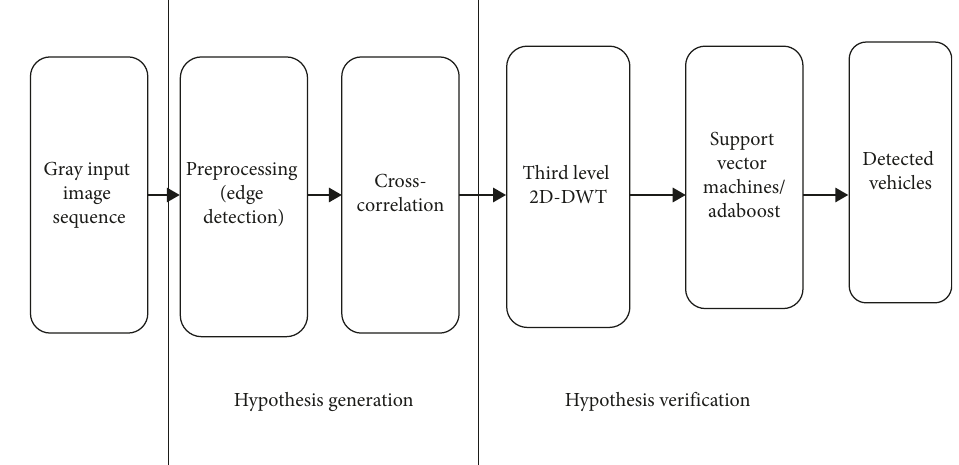
Figure 1: Overall flow diagram of our vehicle detection algorithm.